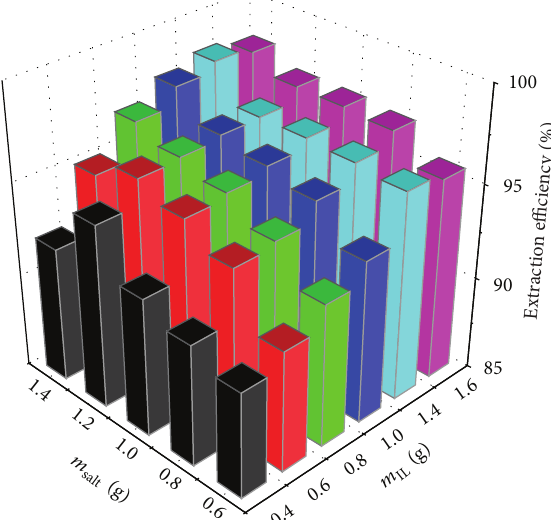
HPO and (2) ATPSs 2 4